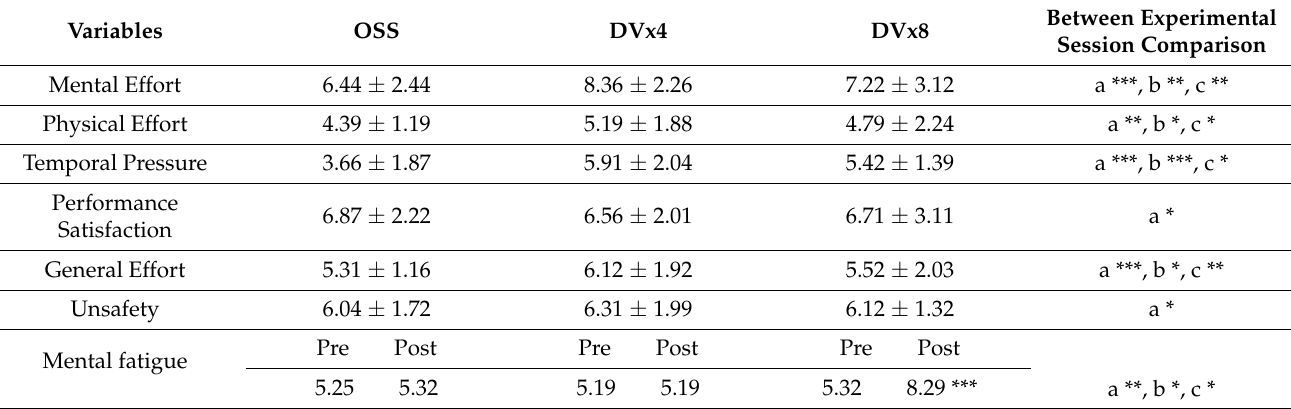
Table 1. Mental load and fatigue reported by players. A comparison between experimental sessions.